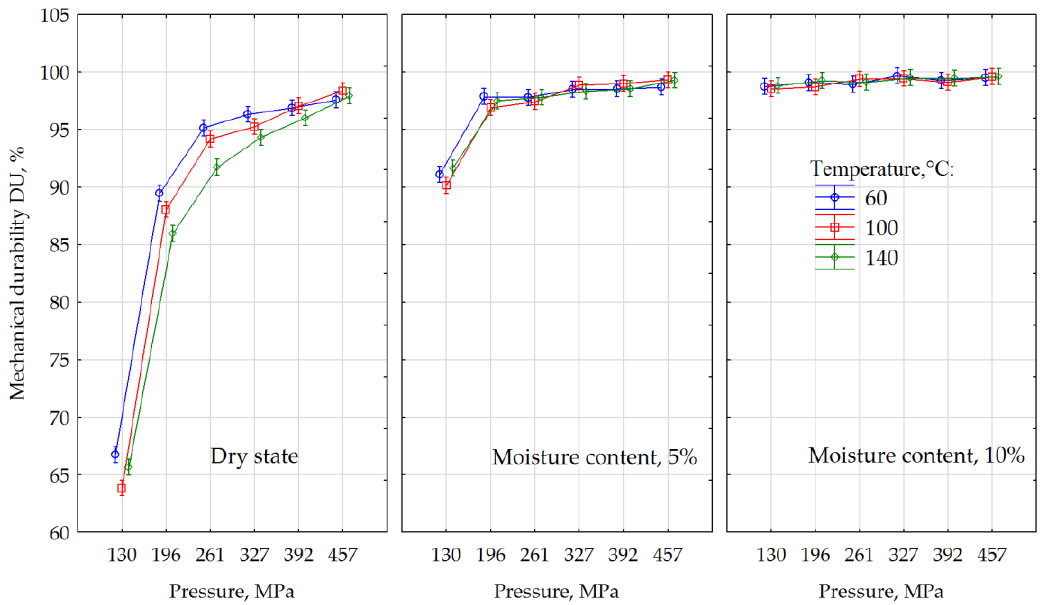
Figure 9. Changes in the mechanical durability ( DU) of the pellets for different compaction process parameters.